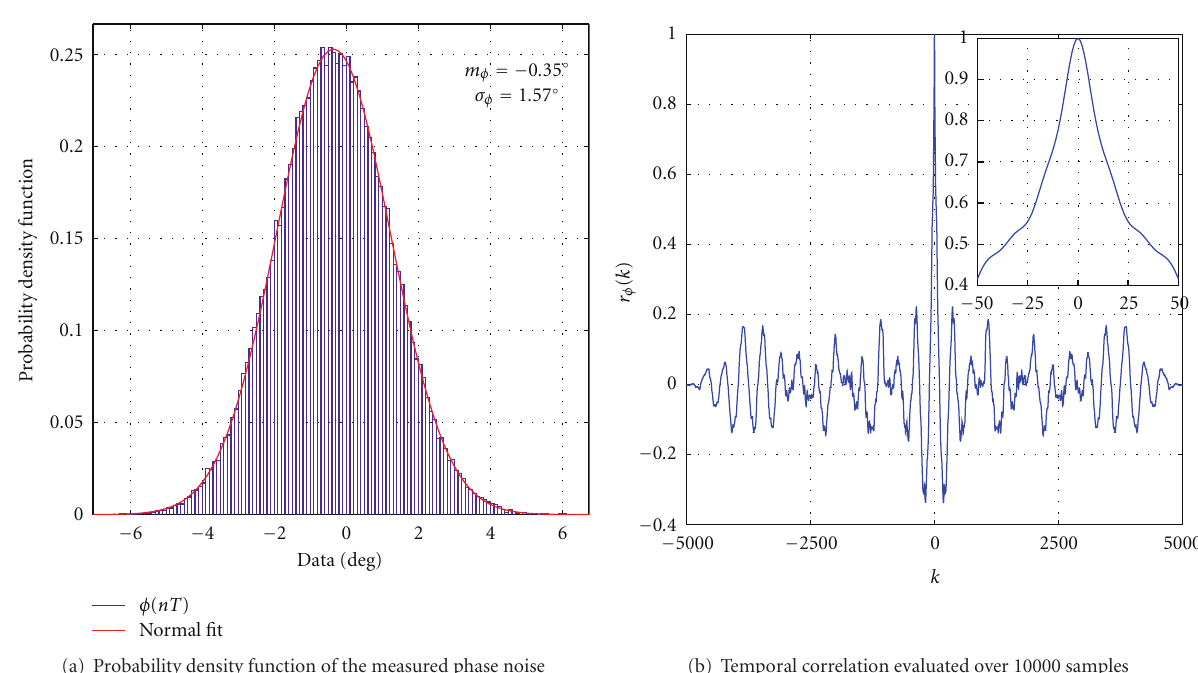
(b) Temporal correlation evaluated over 10000 samples Figure 4: Temporal phase noise